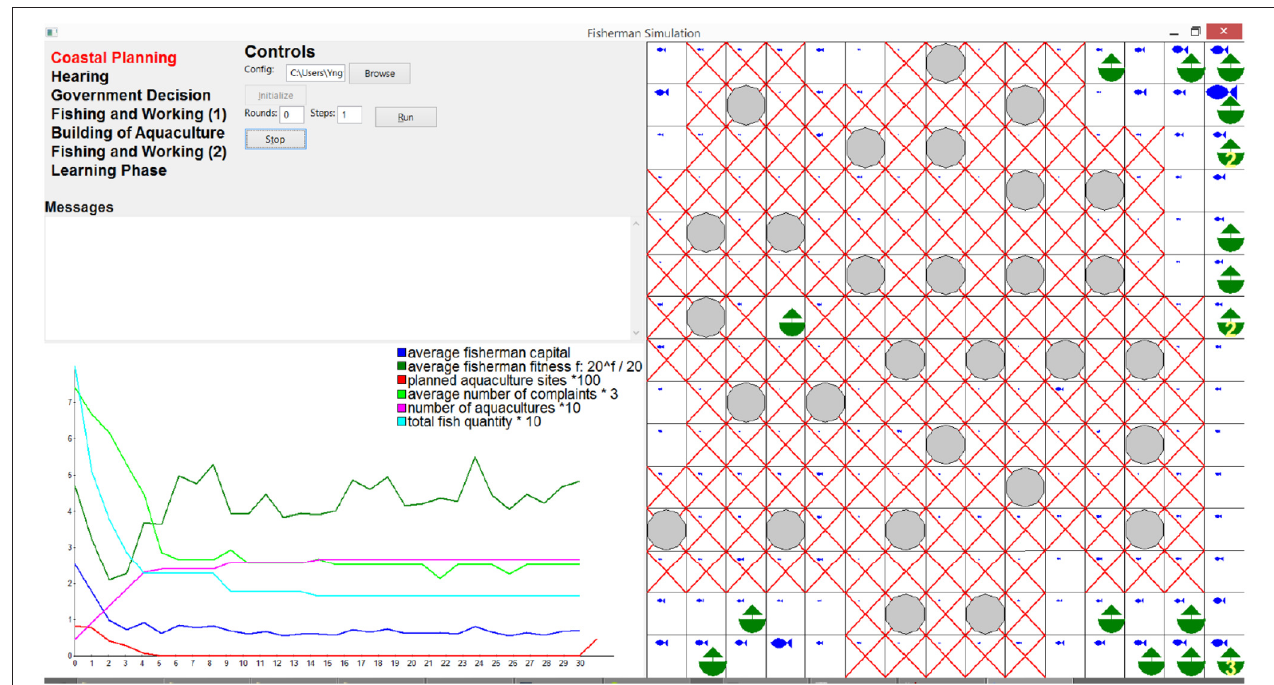
FIGURE 6 | Screenshot of the graphical user interface of